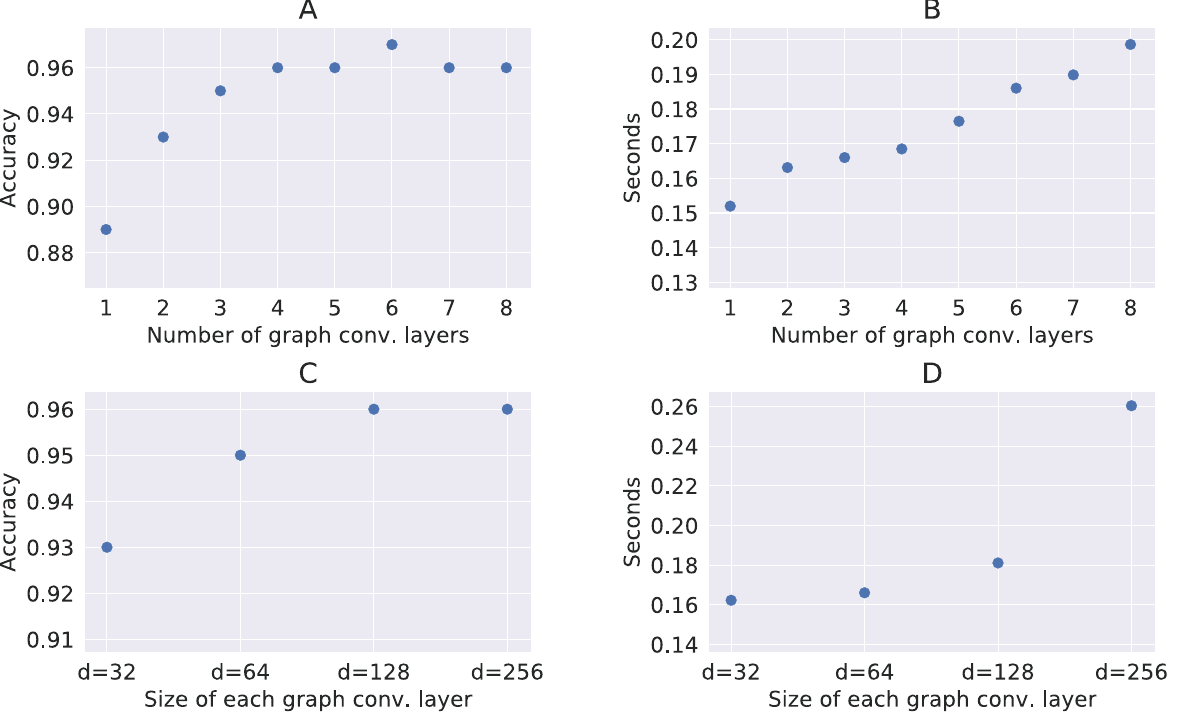
Fig. 5 Comparison of GCN models with different numbers of layers (A), and different sizes of each layer (C). ( A ) demonstrates the accuracy of GCN models with different numbers of layers - from 1 to 8 - on the validation set of Task 1; the size of each layer is 64. ( B ) shows the time in seconds that models from (A) take to train on 100 samples. ( C ) demonstrates the accuracy of GCN models with 3 layers, but different sizes of layers - from 32 to 256. ( D ) shows the time in seconds that models from (C) take to train on 100